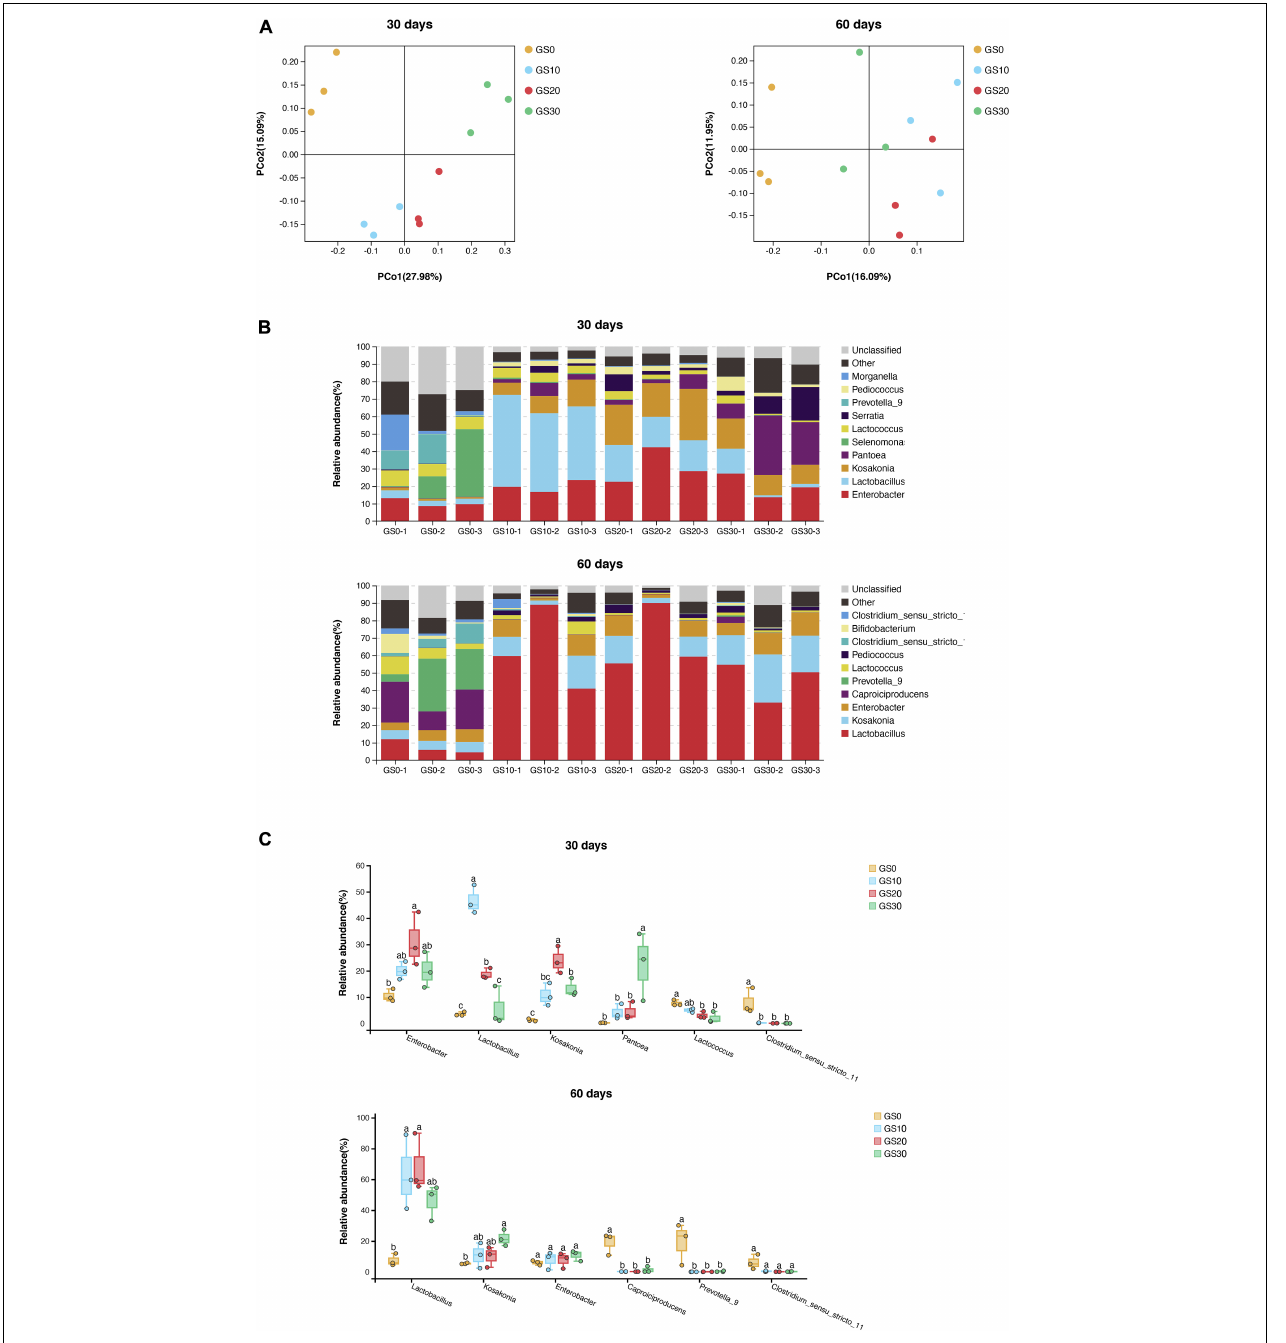
FIGURE 3 | Principal coordinate analysis (A) , relative abundance by genus (B) , and dominant genus ( C , > 5% relative abundance at least one group) of bacterial community for Pennisetum hydridum ensiled with garlic skin at days 30 and 60 of ensiling (GS0, 100 wt% Pennisetum hydridum ; GS10, 90 wt% Pennisetum hydridum + 10 wt% garlic skin; GS20, 80 wt% Pennisetum hydridum + 20 wt% garlic skin; GS30, 70 wt% Pennisetum hydridum + 30 wt% garlic skin). Different letters indicate a significant difference ( P <